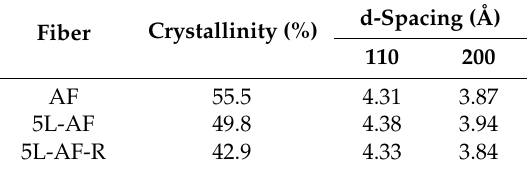
Figure 3. X-ray diffraction of aramid fibers before and after treatment with layer-by-layer self-assembly of L -PDOPA and electrostatic adsorption acidification of silane coupling agents (KH550). Table 1. Crystalline parameters of aramid fibers before and after treatment with layer-by-layer (KH550).